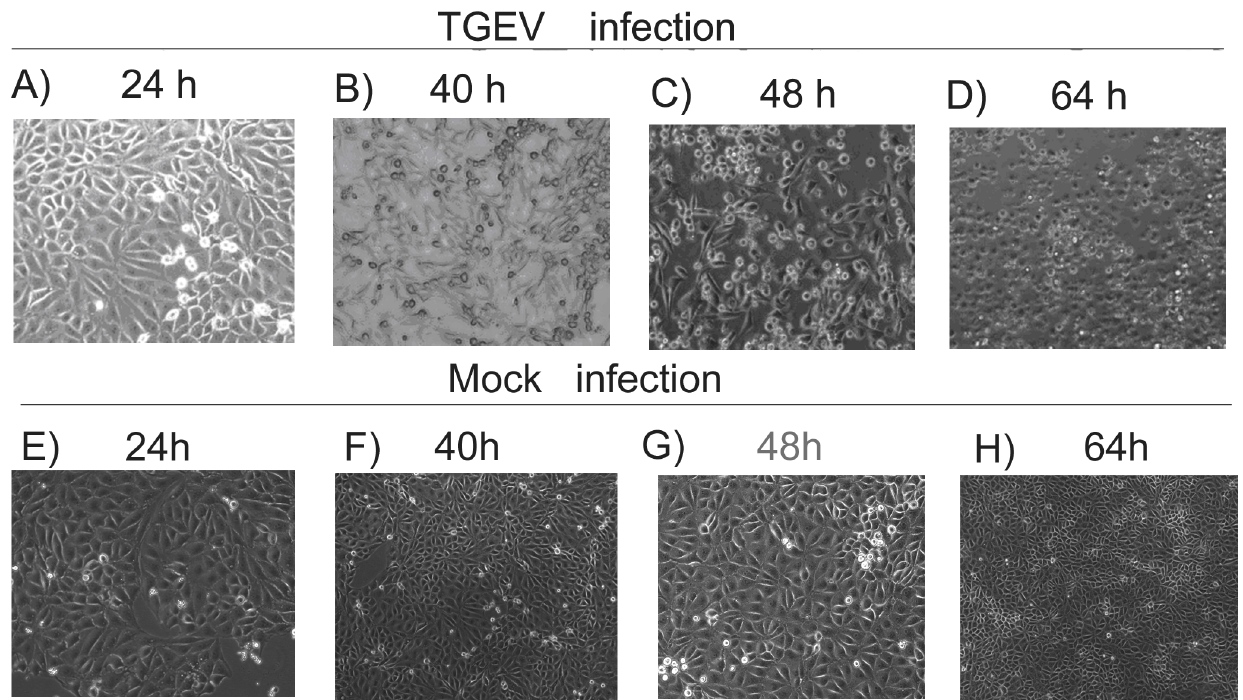
Figure 1. Morphological changes in TGEV-infected cells. ST cells were seeded into 6-cm culture plates, infected with TGEV, and the cytopathic effects (CPEs) were imaged at 24 (A), 40 (B), 48 (C), and 64 (D) hours following infection. Images of non-infected cells (mock infection) are shown for comparison at each time point (E, F, G, H).